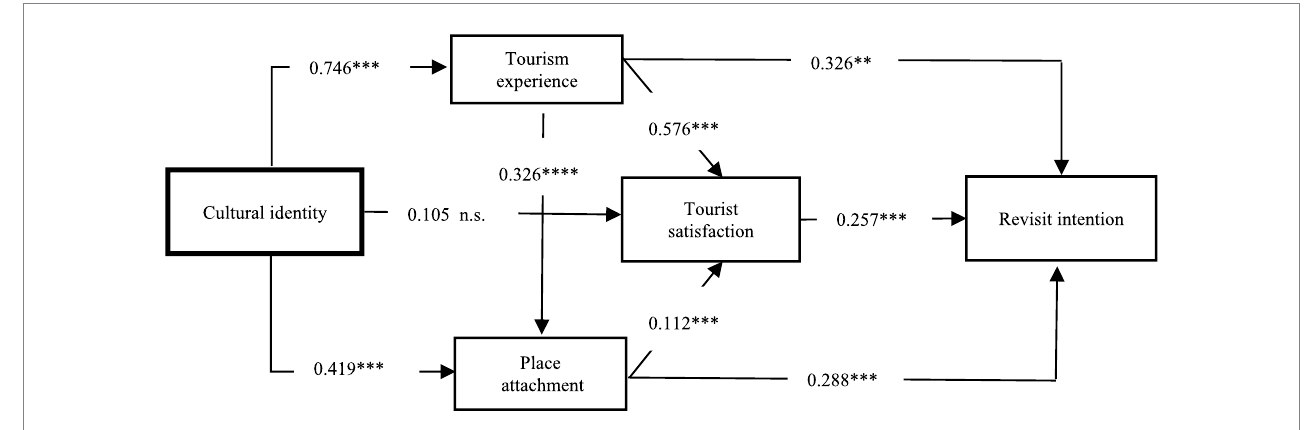
FIGURE 2 Final model with results. **** p value < 0.0001;*** p value < 0.001; ** p value < 0.01; * p value < 0.05; n.s.: not